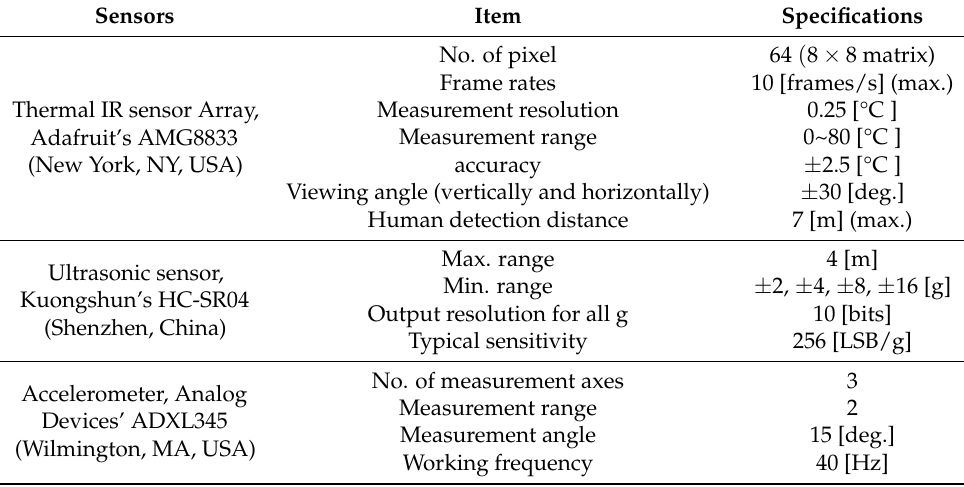
Table 1. Characteristics of sensors used for the prototype robot.